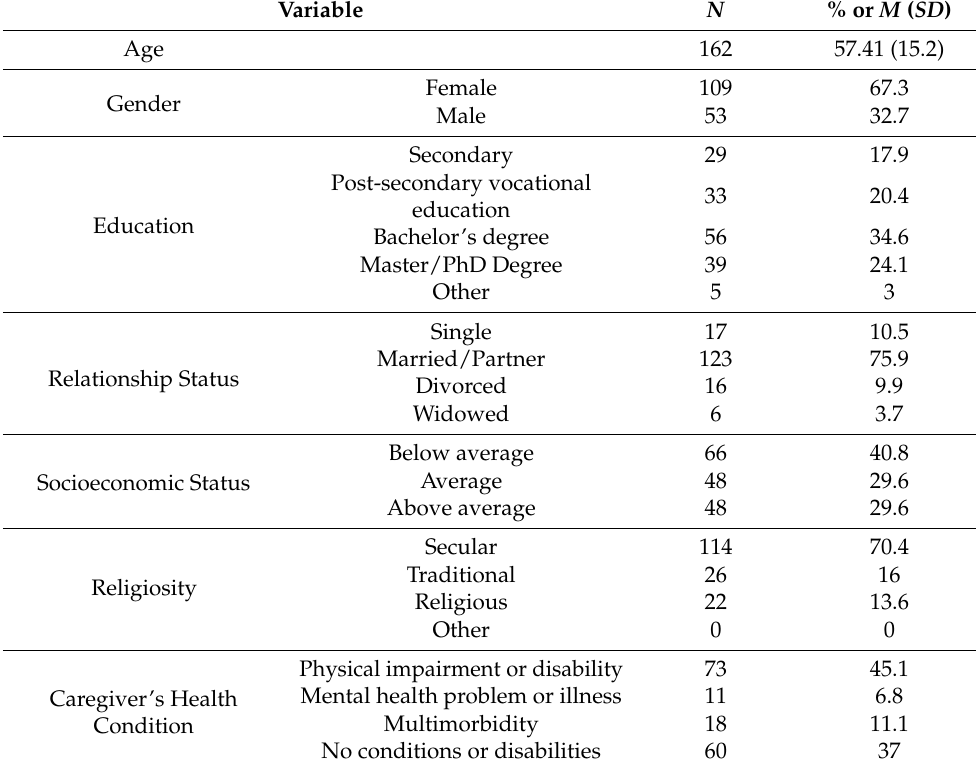
Table 1. Sociodemographic